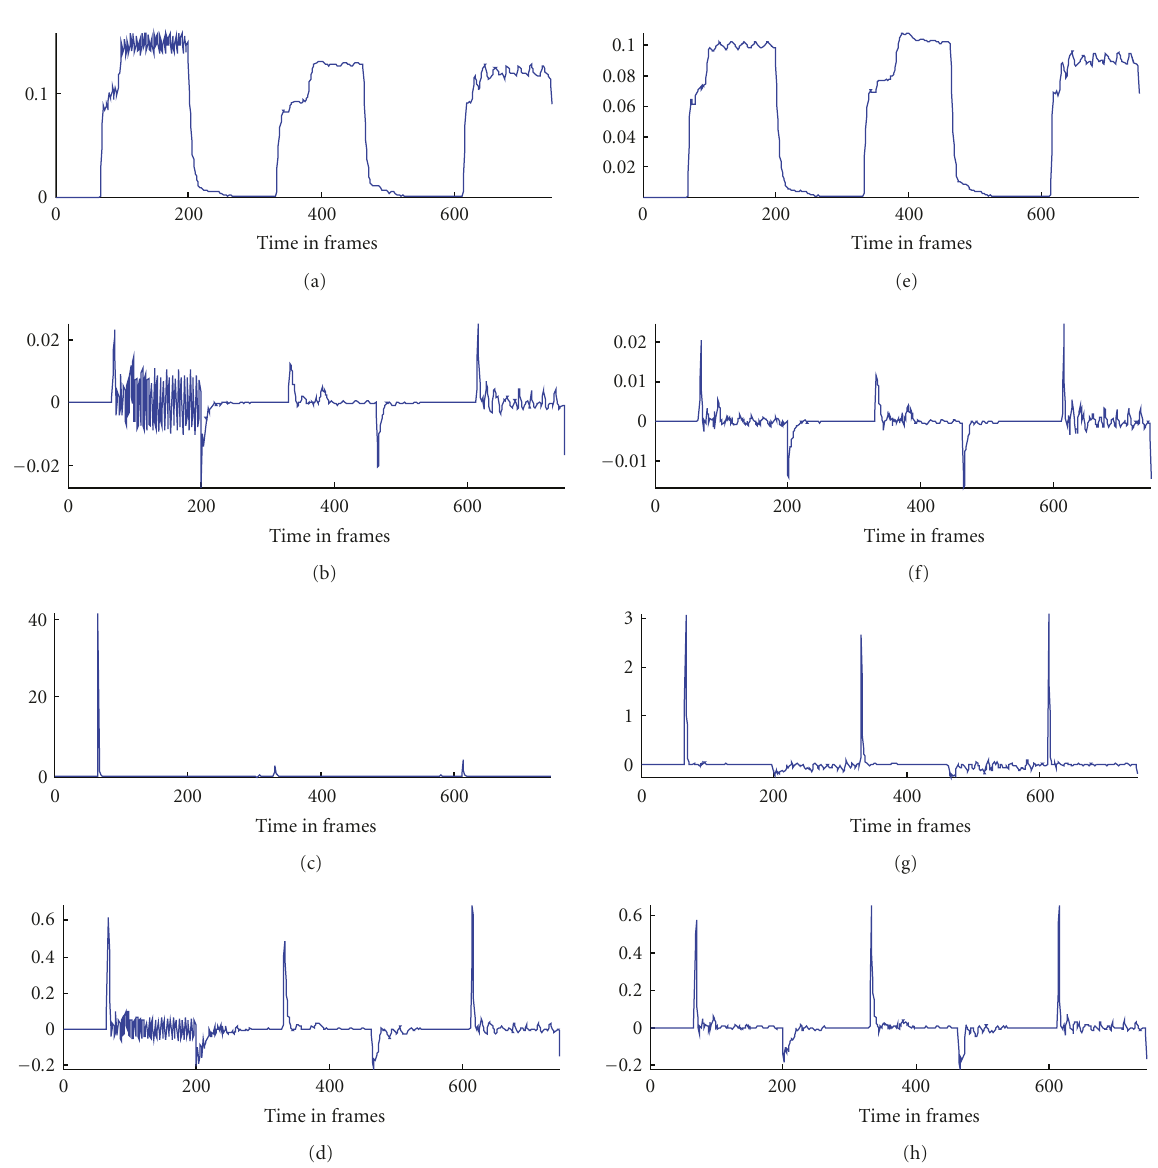
( k ), (g) h o ( k ), and (h) h o ( k ), a r b